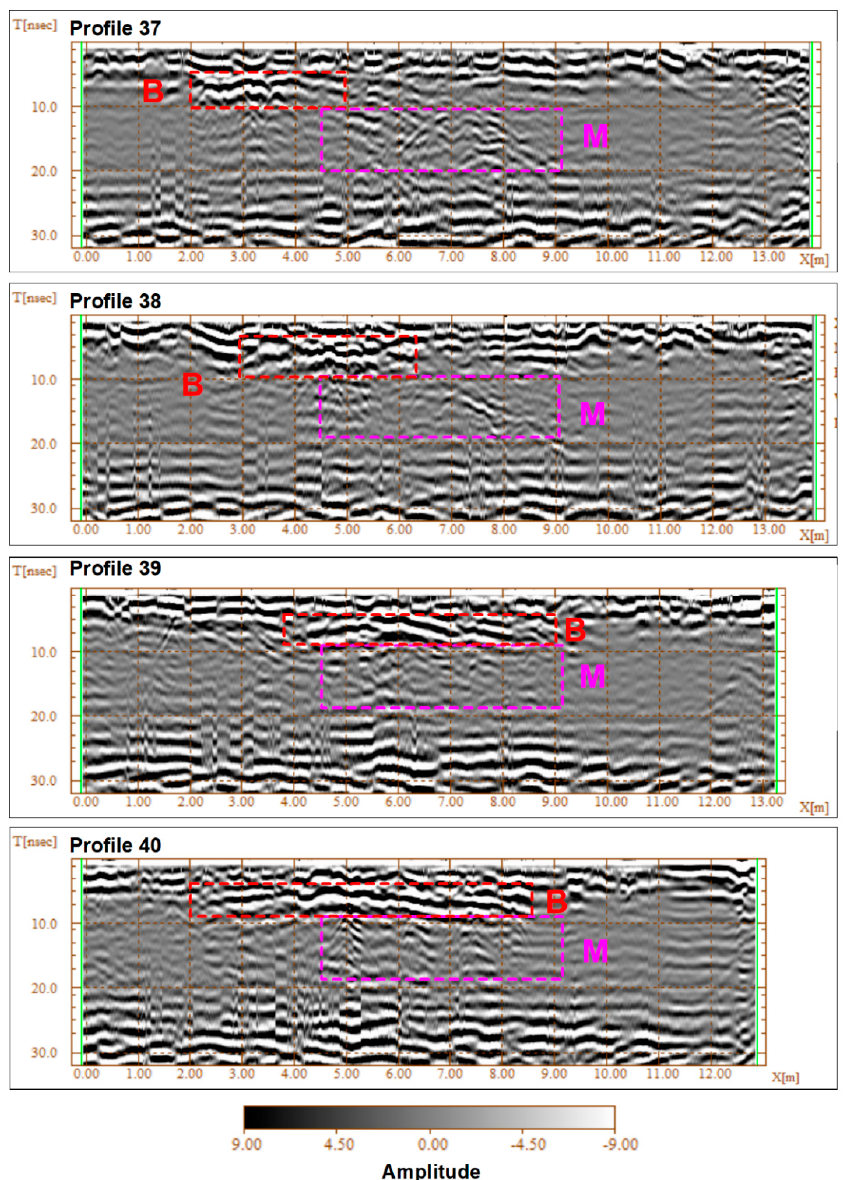
Figure 6. Indication of anomalies on selected longitudinal radargrams from the entire data set relative to the frequency of 600 MHz. to the frequency of 600